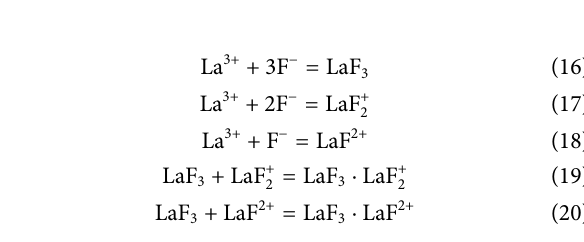
FIGURE 7 | Schematic diagrams of species in La-F-Cl-H 2 O aqueous